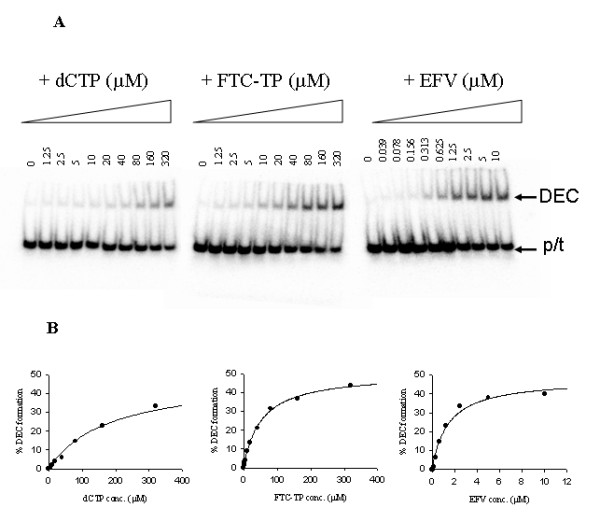
DEC formation by HIV-1 RT, TFV-terminated DNA 26/50-mer. (A) DEC formation by dCTP, FTC-TP, or EFV analyzed on a 6% non-denaturing polyacrylamide gel. (B) Quantification of the DEC formed by TFV-terminated DNA with HIV-1 RT in the presence of dCTP, FTC-TP, or EFV. Please note that the EFV x-axis is scaled significantly different from dCTP and FTC-TP. The amounts of free primer/template and DEC where quantified, and the percentage of DEC formed was plotted as a function of the concentration of dCTP, FTC-TP, or EFV. The solid line represents curve fitting of the data using the single ligand binding equation y = (Bmax × [ligand])/(Kd + [ligand]). The DEC formation by TFV-terminated DNA/RT in the presence of dCTP yielded Bmax = 49.2 ± 2.7% and Kd = 185 ± 28 μM (left panel); The DEC formation by TFV-terminated DNA/RT in the presence of FTC-TP with Bmax = 50.4 ± 1.1% and Kd = 52.6 ± 3.4 μM (middle panel); The DEC formation by TFV-terminated DNA/RT in the presence of EFV with Bmax = 48.0 ± 2.7% and Kd = 1.43 ± 0.25 μM (right panel).